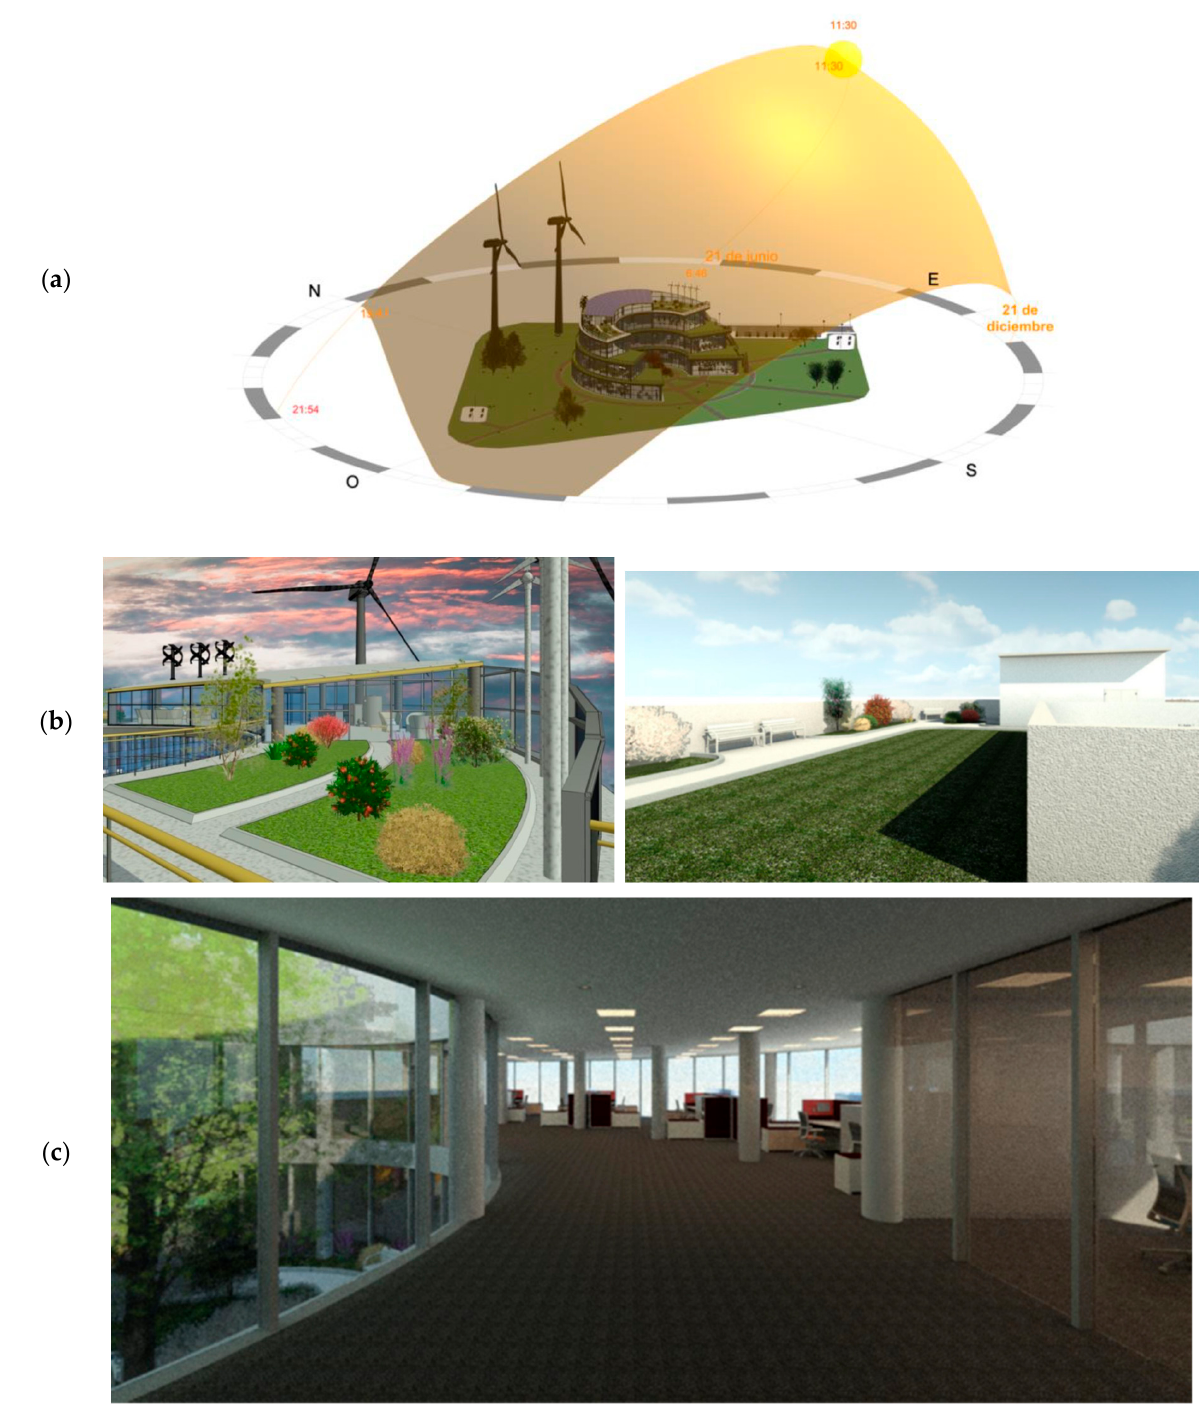
Figure 5. Sustainability strategies: ( a ) Solar study. Revit model ( b ) Examples of vegetation cover. Revit model; ( c ) distribution of spaces, interior administrative area. Revit model